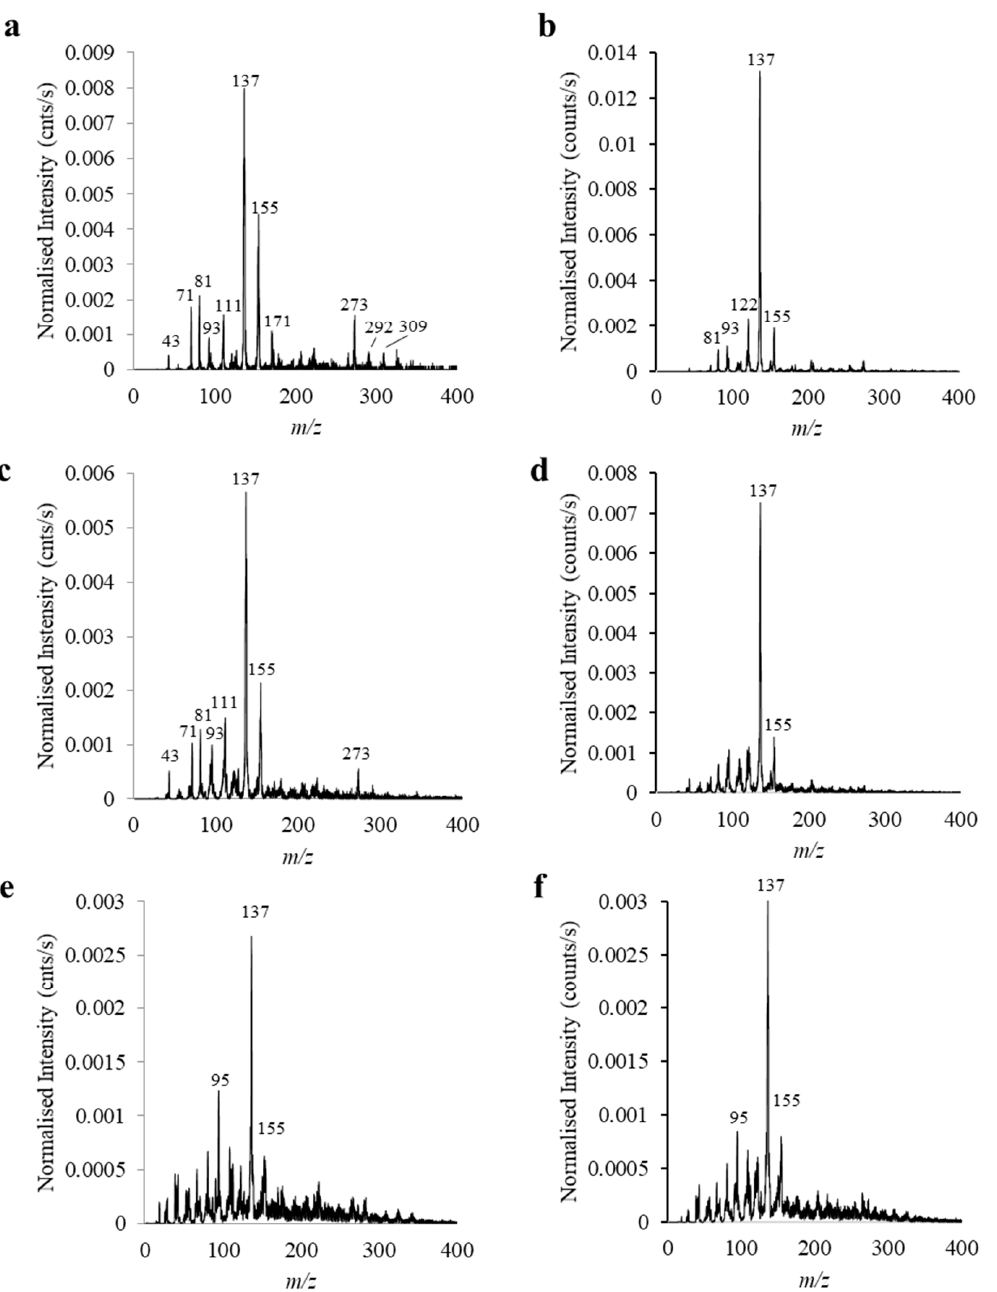
Figure 3. PIM mass spectra for terpinen-4-ol at R.F. plasma powers of ( a ) 5 W, ( c ) 25 W, and ( e ) 50 W, and the parent M. alternifolia oil at R.F. plasma powers of ( b ) 5 W, ( d ) 25 W, and ( f ) 50 W. Table 4. Peak assignment in terpinen-4-ol PIM mass spectra.